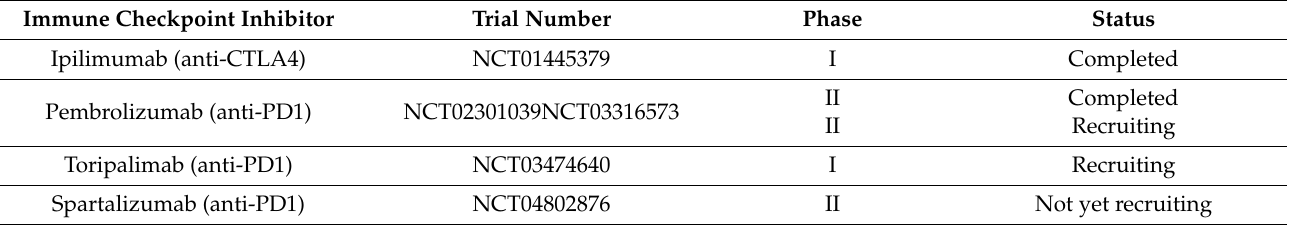
Table 2. Selected immunotherapy trials in STS a .